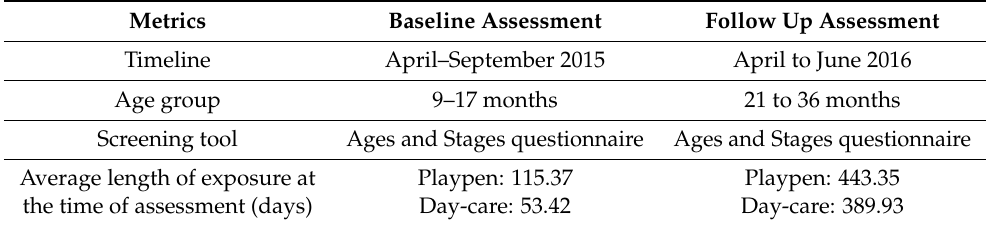
Table 1. Exposure characteristics for the sample